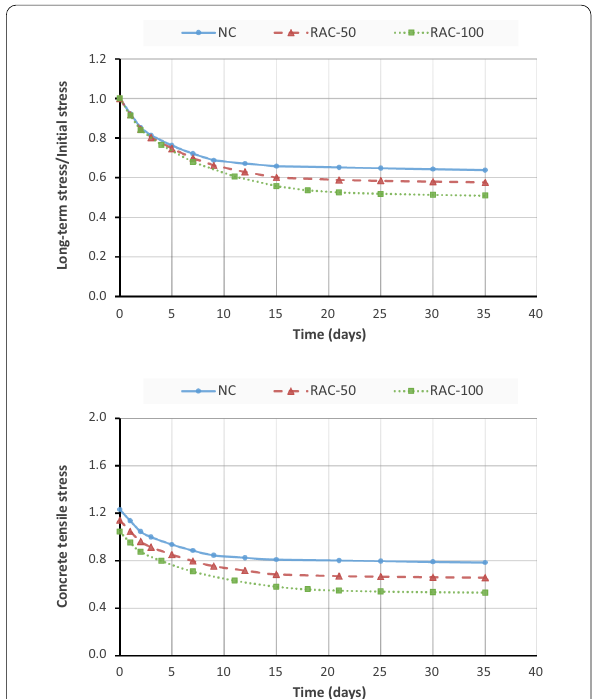
Fig. 10 Effect of recycled aggregate on the long-term loss of tension stiffening